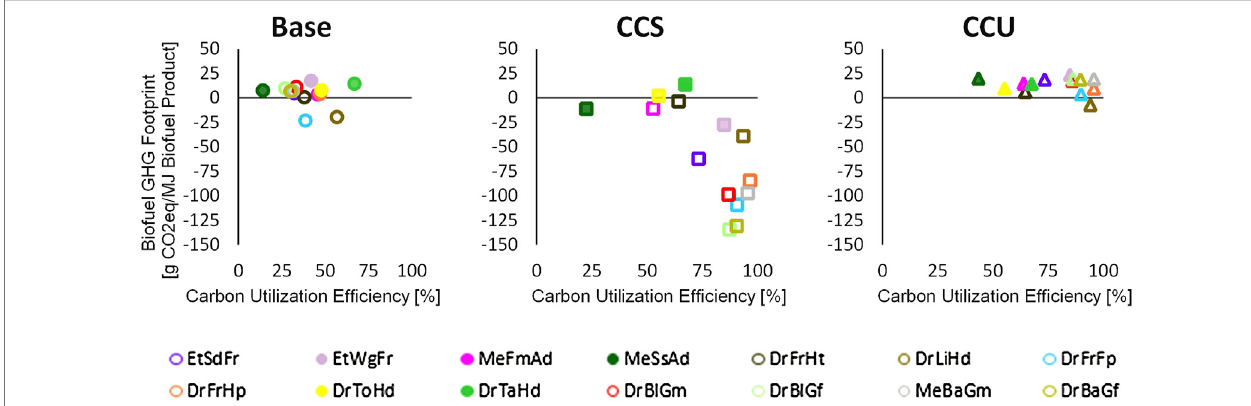
FIGURE4| Carbon utilizationef fi cienciesandgreenhousegasfootprintsunderthebase(circles),carboncaptureandstorage(CCS)(squares)andcarbon capture andutilization(CCU)(triangles)options.Emptymarkersrepresentemergingpathwaysand fi lledmarkersrepresentcommercialpathways.Seethetextforanexplanation for why some of the pathways offer negative emissions under the CCU